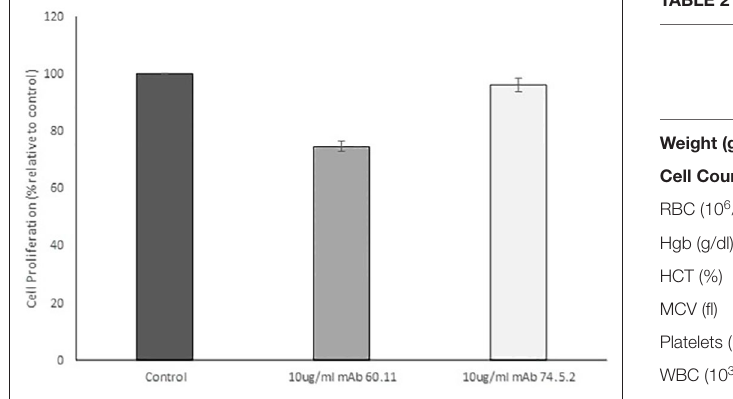
FIGURE 4 | Antibodies directed against the C1q binding site of gC1qR decrease mesothelioma cell proliferation. MSTO-211H cells was treated with 10 µ g/mL monoclonal anti gC1qR antibody mAb 60.11 directed against the C1q binding region (aa 76–93) or mAb 74.5.2 directed against the high molecular weight kininogen binding domain (aa 204–218). Cell proliferation was determined via hemocytometer cell counts of viable cells after 96h incubation. Error bars represent mean cell population ± standard deviation. n = 2 separate experiments performed in duplicate. *Significant difference from control at p = 1.33 × 10 − 5 .